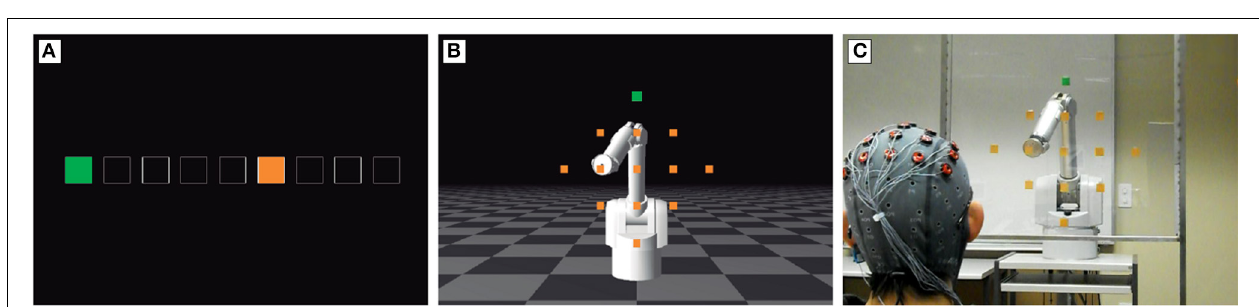
at electrode FCz for correct, error and difference (error minus correct) conditions. t = 0 corresponds to the stimulus presentation onset (i.e., cursor movement). (E,F) Topographical representation of the group average difference ERP for both the interaction ( N = 4) and monitoring paradigms ( N = 6). Activity is color coded from blue to red corresponding to the range [ − 5 5]uV.